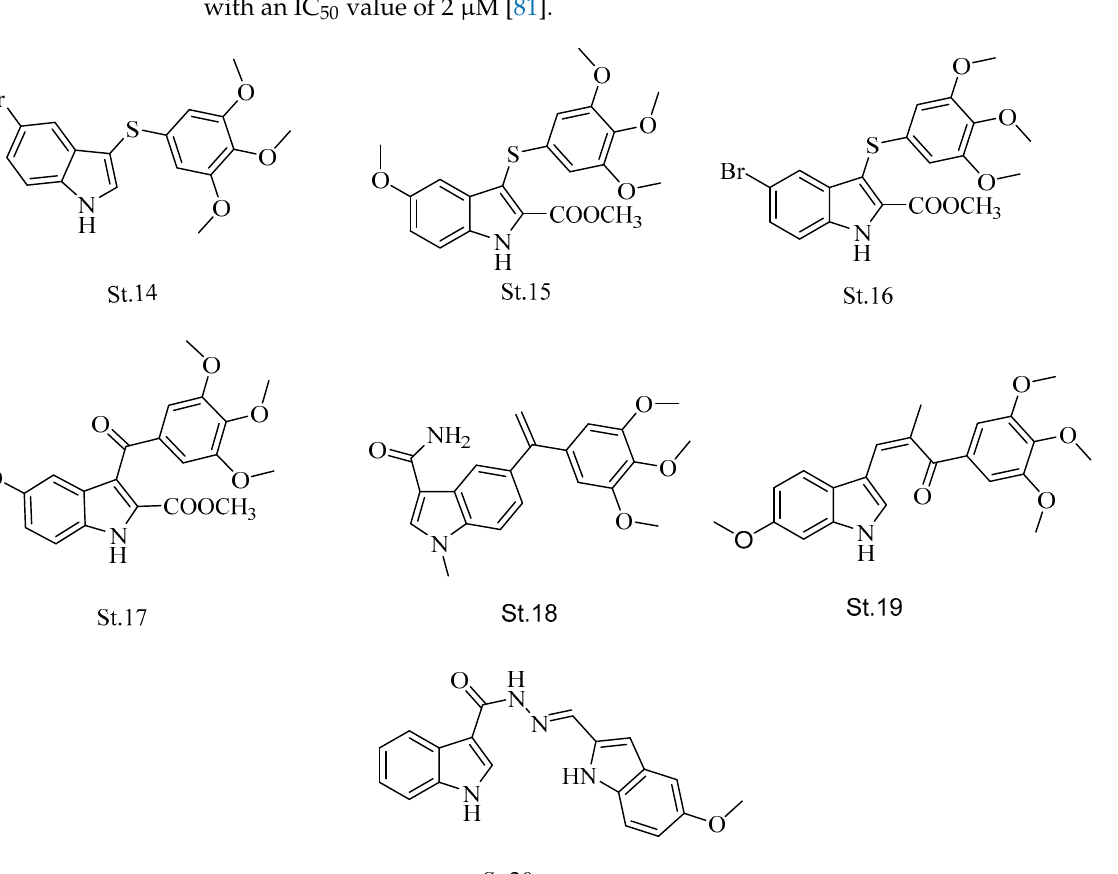
tent antimitotic effects in human cancer cell lines, as well as potent antiproliferative activ- ities against various kinds of cancer cell lines such as glioblastoma, breast, and gastric cancer cells [84]. In another study, aroylindole derivatives were discovered and synthe- sized as potent antitumor and antimitotic agents, St.23 and St.24 (Figure 7), with OH and NH2 at the 4th position of indole showing potent anti-tubulin activity with IC 50 values of 0.6 and 0.9 μ M, respectively. They also showed antiproliferative activity with IC 50 in na- nomolar level against different kinds of cancer cell lines [64,85]. Many kinds of research have been focused to discover hybrid chemical agents with antimitotic activities [86], including indole-heterocycles hybrids derivatives with promis- ing anticancer activities [87,88]. Pyrazole-oxindole derivatives were also developed and evaluated on tubulin polymerization, and different kinds of cancer cell lines such as HeLa, A549, and MCF7, St.25, St.26, and St.27 (Figure 7), exhibited anti-tubulin activities with IC 50 values in the range 5.90–9.20 μ M [89]. Meanwhile, St.28 (Figure 7) with indole-amino- pyrazolyl derivatives was synthesized and inhibited tubulin polymerization with IC 50 val- ues of 0.28 μ M [90]. In new research on a indole-furanone hybrid, derivatives were syn- thesized and developed as anti-tubulin derivatives; the most potent compound, St.29 (Fig- ure 7), has anticancer and antimitotic potency at the micromolar level [91]. In another re- cent work, the authors developed and synthesized an indole-heterocycle hybrid like the furan ring, and these structures showed potent antiproliferative activities. Among the synthesized compounds, St.30 (Figure 7) was able to induce cell cycle arrest at the G2/M phase on A549 cancer cell line. Additionally, this structure also exhibited tubulin